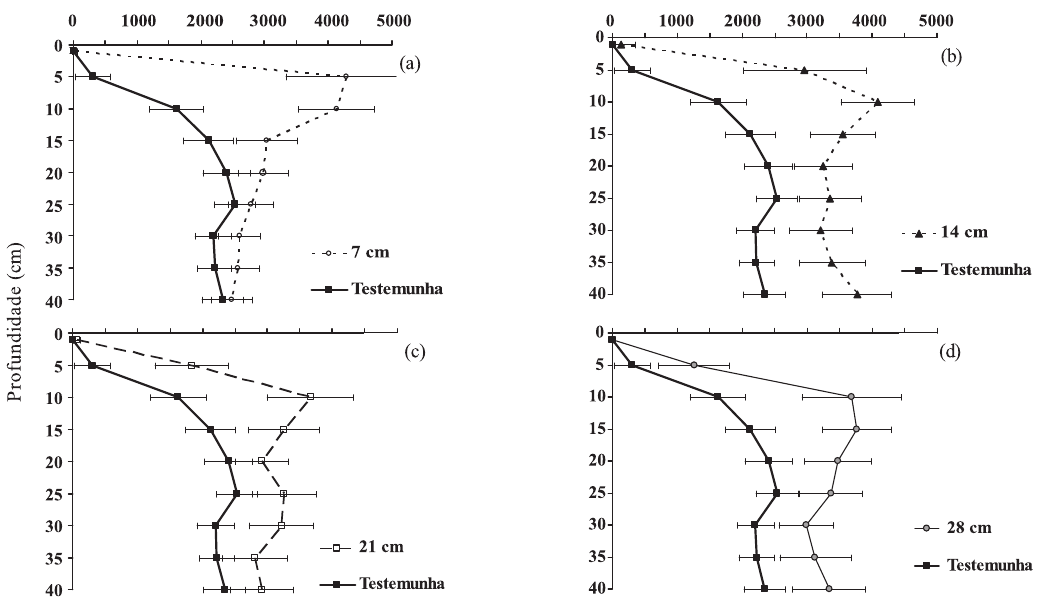
Figura 5. resistência do solo à penetração (rP) para as alturas de pastejo de 7 (a), 14 (b), 21 (c) e 28 cm (d), comparadas com a testemunha, até a profundidade de 40 cm. As barras referem-se ao intervalo de confiança da média, e a sobreposição dos intervalos de confiança indica ausência de diferenças entre os